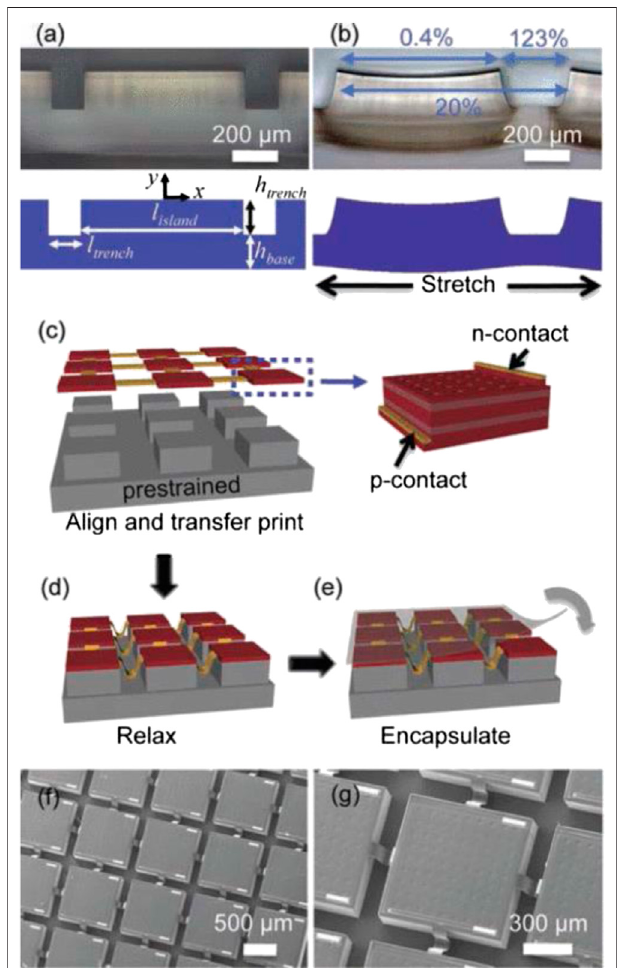
FIGURE 7 | Optical microscopy images and FEA calculations of deformation of a slab of PDMS and schematic illustrations of the steps in the fabrication of stretchable GaAs photovoltaic modules with SEM images of a completeddevice.Cross-sectionalopticalmicroscopyimages (top) and FEA (bottom) ofaslabofPDMSin (A) relaxedand (B) stretchedstates,witha square array of raised islands separated by recessed trenches, designed as a platform for (C) stretchable inorganic photovoltaics with high areal coverages. (D) Releasingtheprestrainand pressingontheentirearrayusinga fl at plateof glass deform the interconnects into arc shape, in a vertical downward orientation, into the trench regions ofthe PDMS substrate. (E) In a fi nal step, a thin,uniformlayerofPDMSisbondedonthetop,asanencapsulanttoprotect the system from the environment. (F) and (G) SEM images of a completed module (Lee et al., 2011). Reproduced with permission.